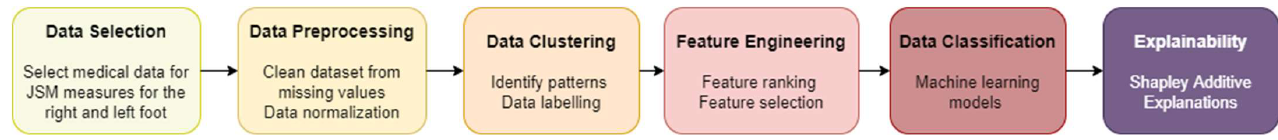
Figure 1. Methodology flowchart.